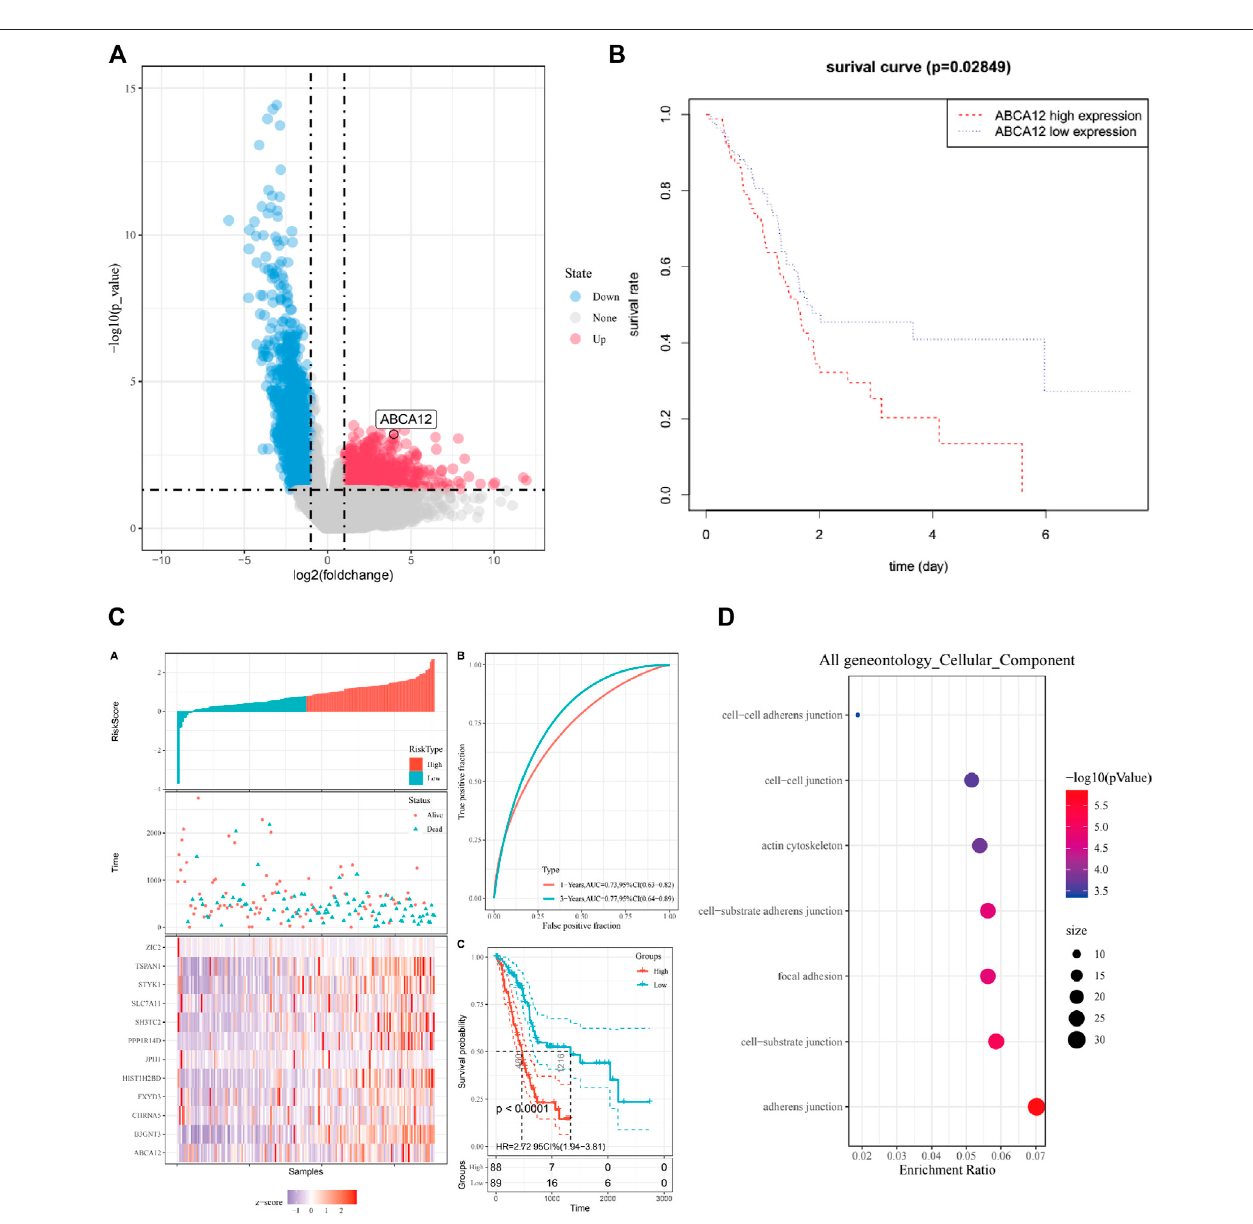
FIGURE 2 | Bioinformatics analysis of ABCA12 . (A) Volcano map of differential genes in TCGA pancreatic cancer database. (B) Survival curve of patients expressing ABCA12 in TCGA database. (C) Prediction model of risk score for highly expressed genes in TCGAdatabase. (D) Bubble map of GO enrichment analysis of ABCA12 coexpressed genes in TCGA pancreatic cancer